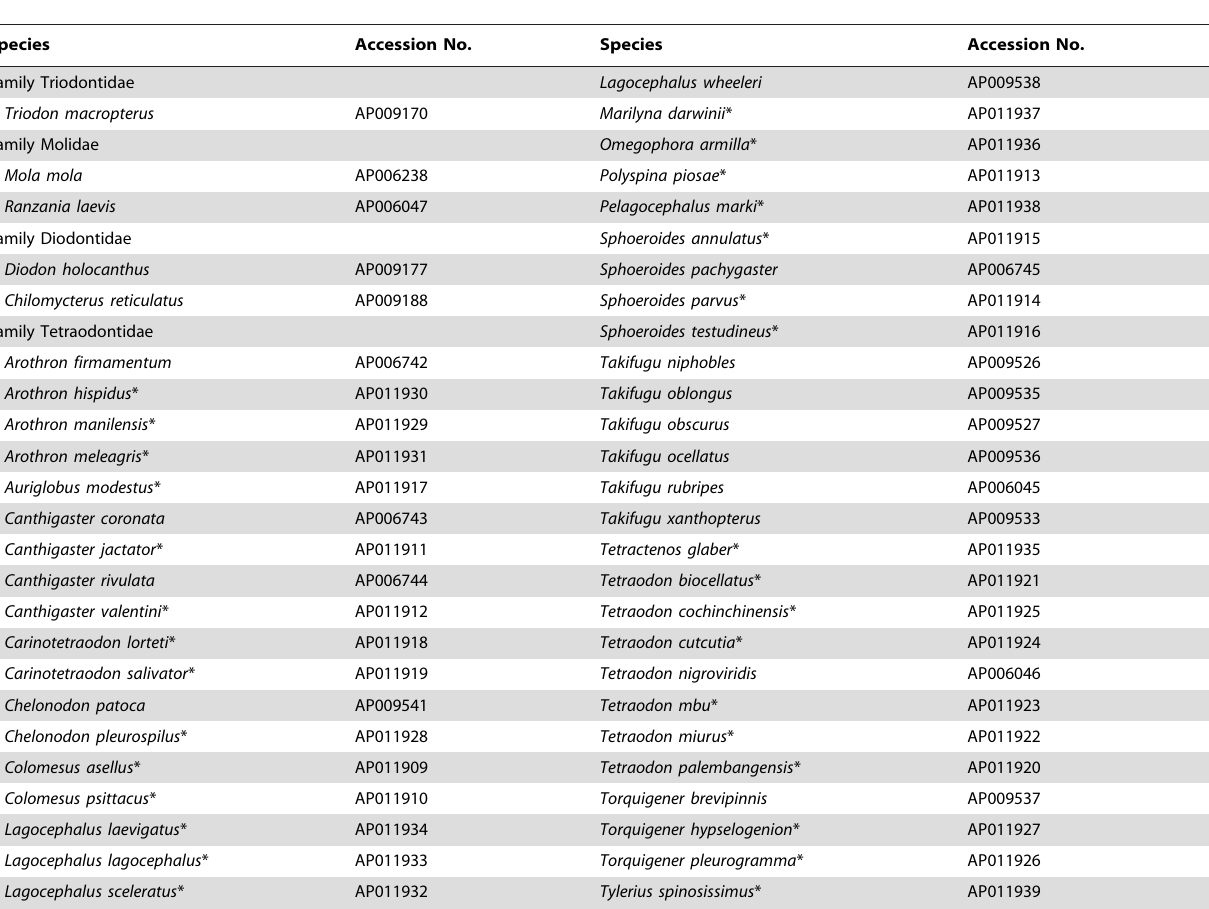
Table 1. List of species analyzed, with DDBJ/EMBL/GenBank accession numbers. Classification follows Froese and Pauly [12].